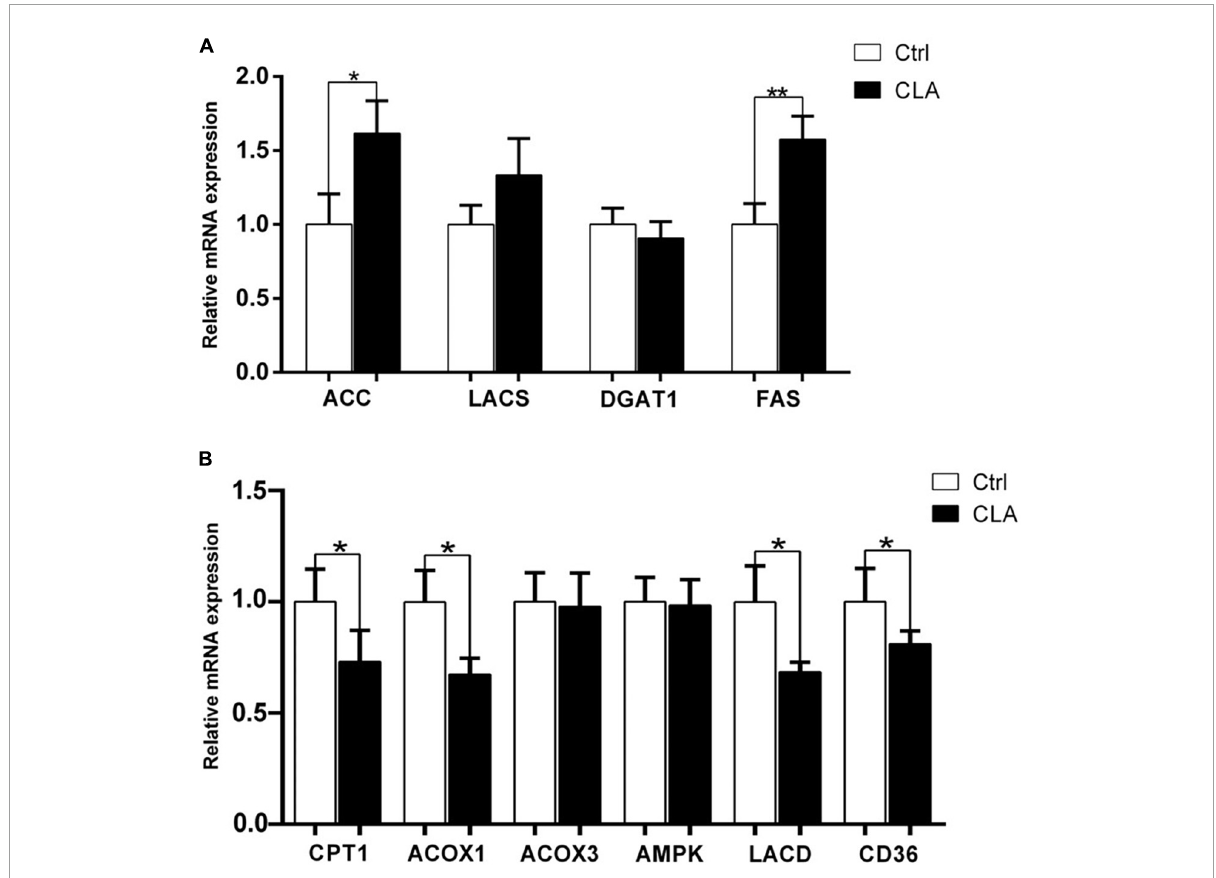
FIGURE5 Dietary CLA regulated the expression of genes involved in fatty acid synthesis and lipid metabolism in the quadriceps femoris of mice. (A,B) RT-qPCR was performed to determine the expression levels of genes related to fatty acid synthesis (ACC, LACS, DGAT1, and FAS) and lipid metabolism (CPT1, ACOX1, ACOX3, AMPK, LCAD, and CD36) in the quadriceps femoris of mice. The expression levels were normalized to GAPDH mRNA levels. Data were analyzed by t -test. * P <